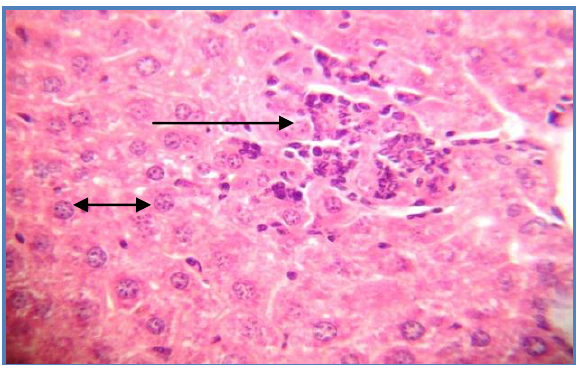
Figure, 9: Liver of mice at 10 days post infection by Candida albicans and treated with 10% of Datura stramonium extract for 8 day ( ) shows aggregation of MNCs in the paranchyma with ( ) proliferation of Kupffer cells (Heamatoxcyline and Eosin stain 40X).